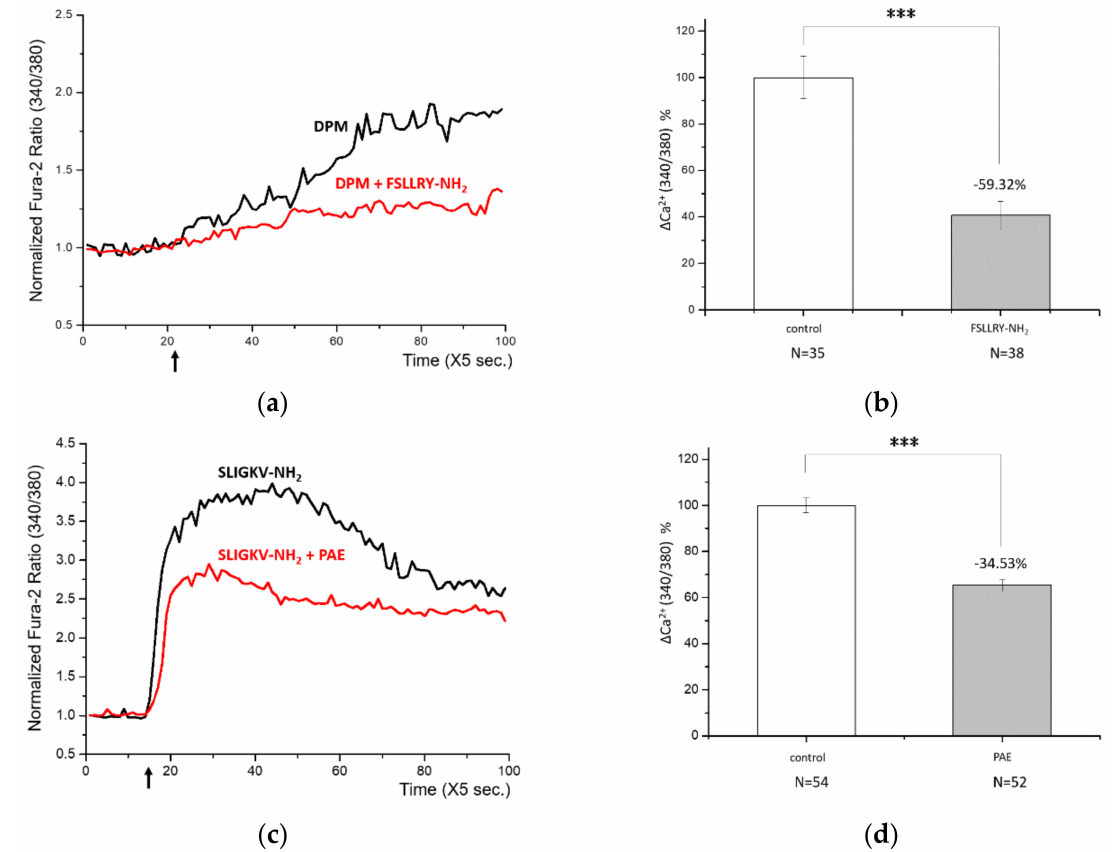
Figure 3. Proteinase-activated receptor-2 (PAR-2) was responsible for the DPM-induced Ca 2+ influx. ( a ) HaCaT cells were treated with DPM only (black) or DPM and 100 µ M FSLLRY-NH2 (red) at the indicated time (arrow). ( b ) DPM-induced Ca 2+ influx was successfully reduced by inhibiting PAR-2. ( c ) HaCaT cells were treated with 100 µ M SLIGKV-NH2 only (black) or SLIGKV-NH2 and PAE (red) at the indicated time (arrow). ( d ) The PAR-2 agonist induced Ca 2+ influx, which was also inhibited by PAE. This result indicates that the effect of PAE was mediated by PAR-2 regulation. (*** p <